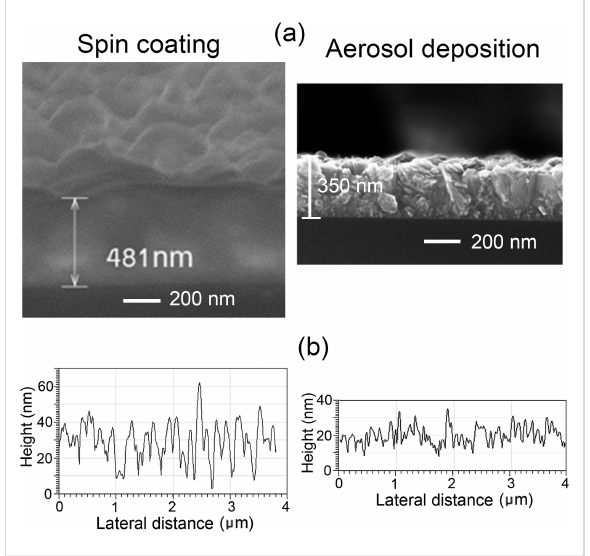
Figure 1: a) SEM images of ZnMgO films deposited on p-Si sub- strates by spin coating (left column) and aerosol deposition (right column) methods. b) Graphical representations of the AFM profiles for ZnMgO films.